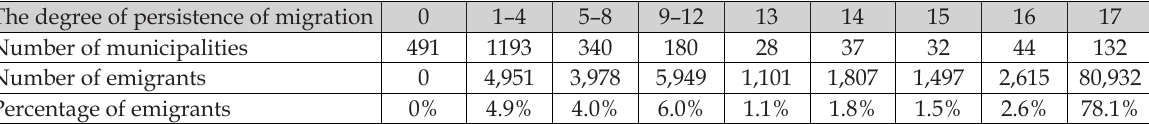
Table 1. The number of emigrants from Wrocław in the years 2002–2018 in municipalities according to the persistence of migration flows.